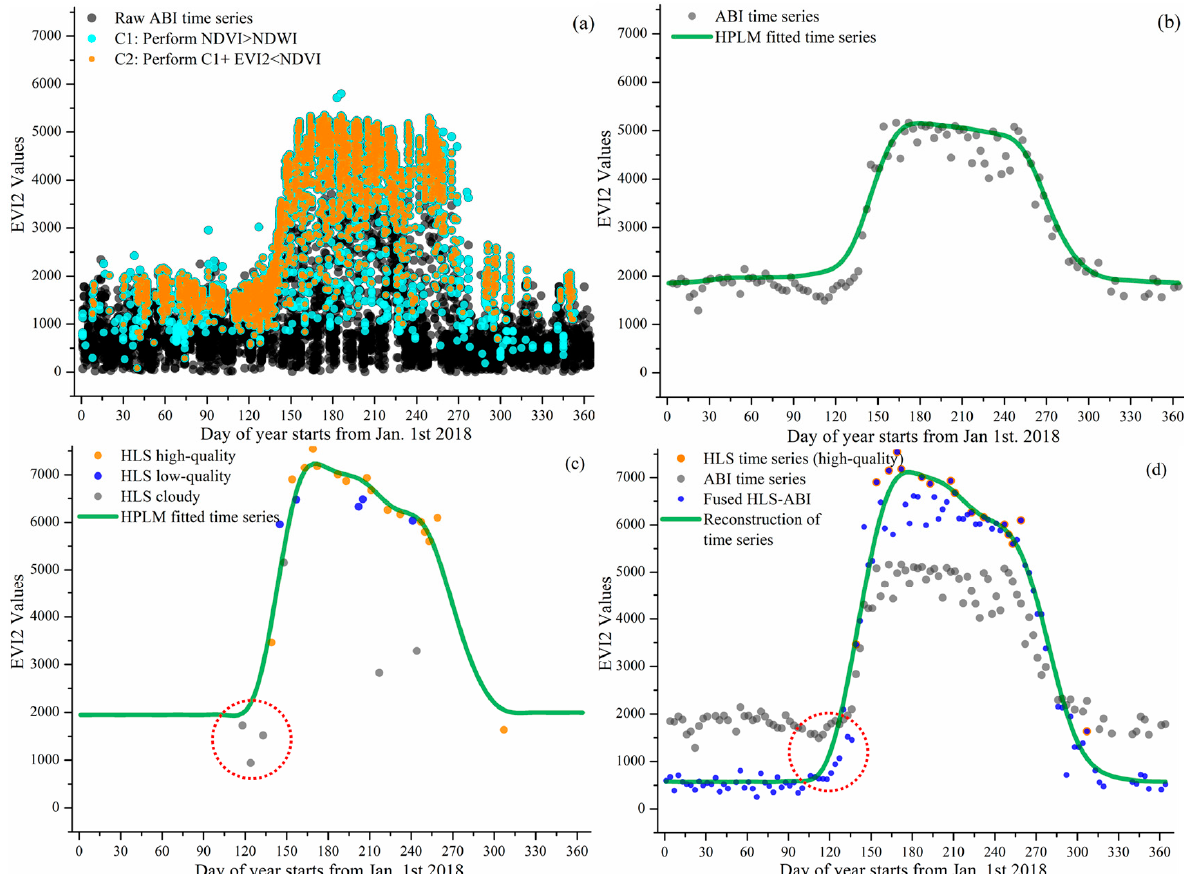
Figure 3. Reconstruction of HLS-ABI time series in a forest pixel. ( a ) denotes the noise reduction process for selecting high-quality ABI observations from raw ABI observations, where the black dots are the results of overlaps from multiple gray dots. ( b – d ) present the reconstruction of EVI2 temporal trajectories from ABI, HLS, and HLS-ABI, respectively. The value in y-axis is multiplied by 10,000.